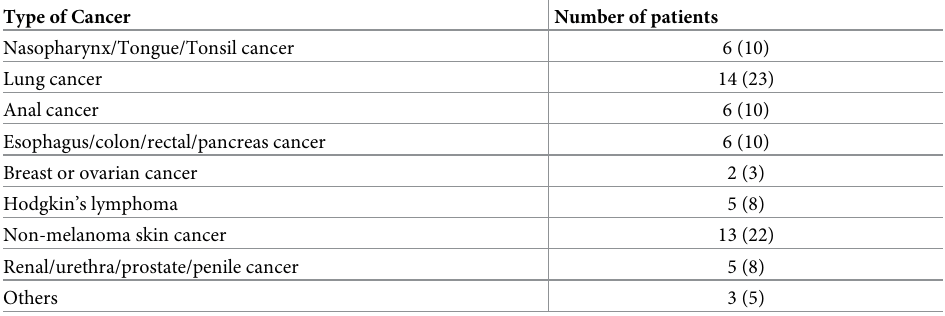
Table 2. The 60 non-AIDS-defining cancers and non HCV-liver related cancers diagnosed in HIV/HCV-coin- fected patients.